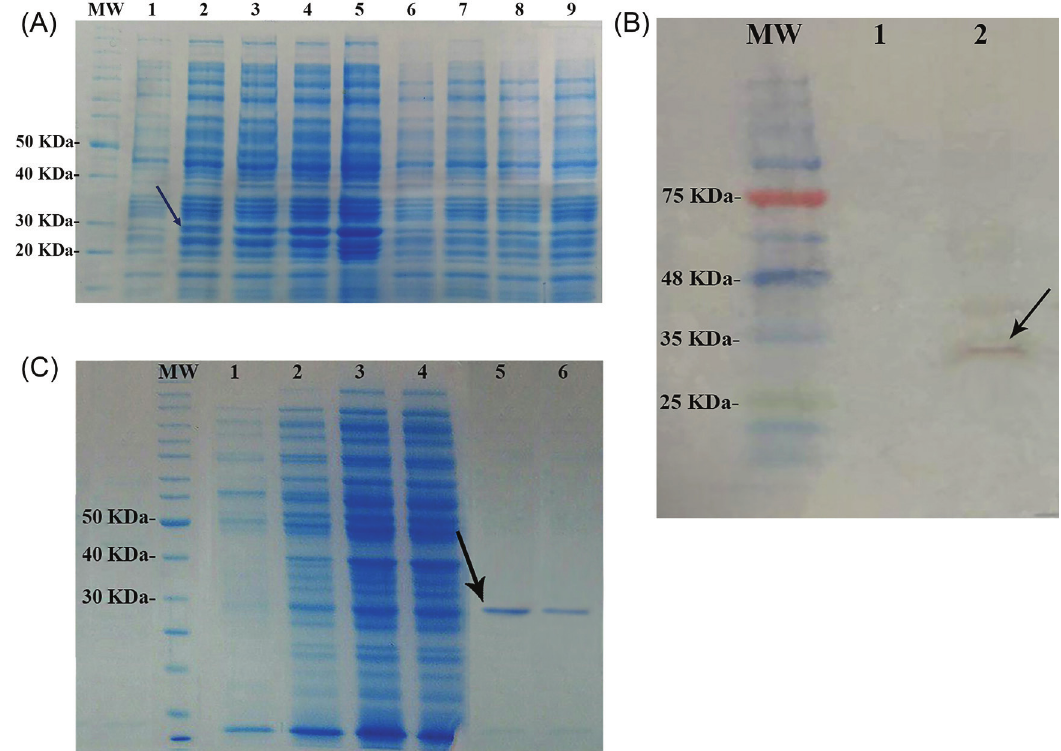
FIGURE 1 - Anti-HER2 scFv expression, purification and Western blot analysis. A) Analysis of anti-HER2 scFv expressed in Origami: Protein marker (Fermentas) (MW), total protein from Origami (DE3) containing pET-22b (anti-HER2 scFv) plasmid before induction (lane 1) after induction with 1 mM IPTG for 2 h (lane 2), 4 h (lane 3), 6 h (lane 4), 24 h (lane 5) at 37 °C, total protein from Origami (DE3) containing pET-22b (without insert) before induction (lane 6), after induction with 1 mM IPTG for 2 h (lane 7), 4h (lane 8), 6 h (lane 9) at 37 °C. B) Western blot analysis of the expressed anti-HER2 scFv using anti His tag antibody: Protein molecular size marker (Sinaclon) (MW), negative control (uninduced Origami (DE3) cell lysate) (lane 1), Origami cell lysate transformed by recombinant plasmid 24 h after induction with 1 mM IPTG (lane 2). C) anti-HER2 scFv purified using polyhistidine (His)-tag affinity column chromatography: Protein marker (Fermentas) (MW), Flowthrough (lane 1), wash 1-3 (lane 2-4), purified anti-HER2 scFv protein elution 1 (lane 5), and elution 2 (lane